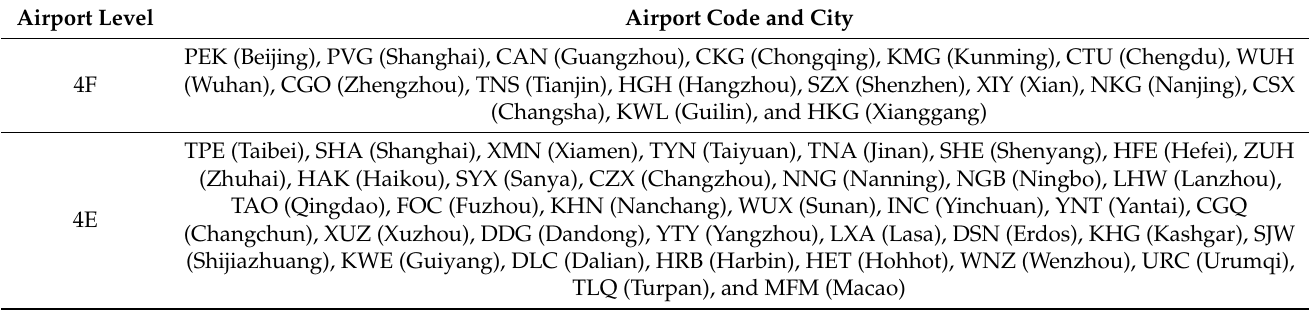
Table 2. Airport level and